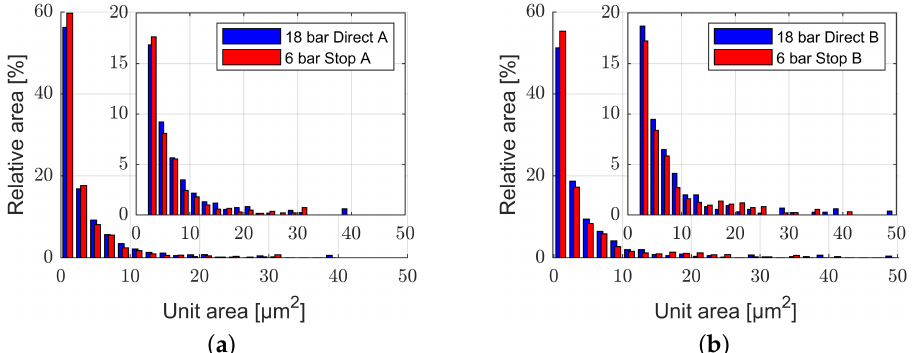
Figure 6. Relative martensite unit area distribution for a binning size of 2 µ m 2 with inset for units larger than 2 µ m 2 for 18 bar Direct and 6 bar Stop ( a ) 20MnCr5 (A) and ( b ) 17NiCrMo6-4 (B).